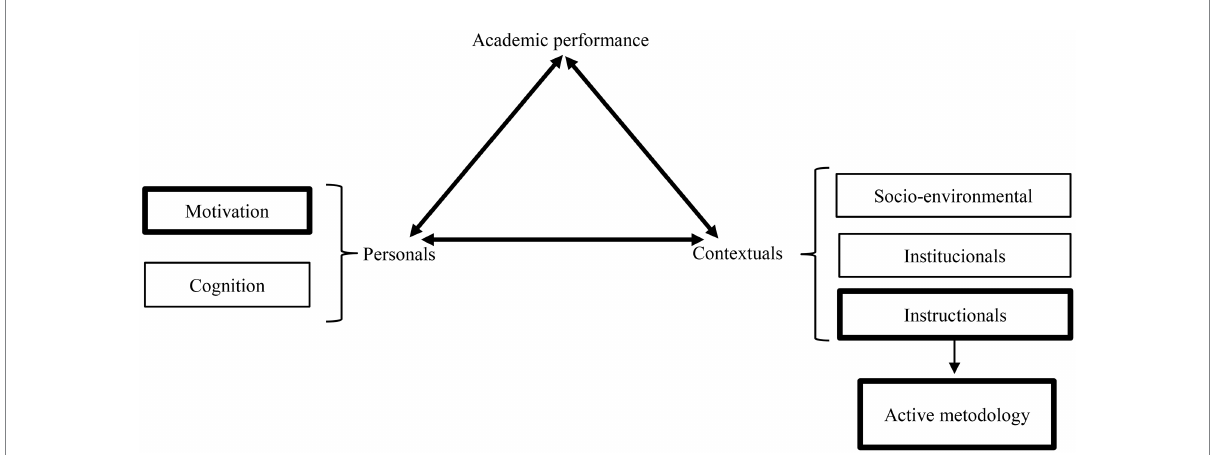
FIGURE 1 Relationship between academic performance, learning motivation, and teaching methodology.